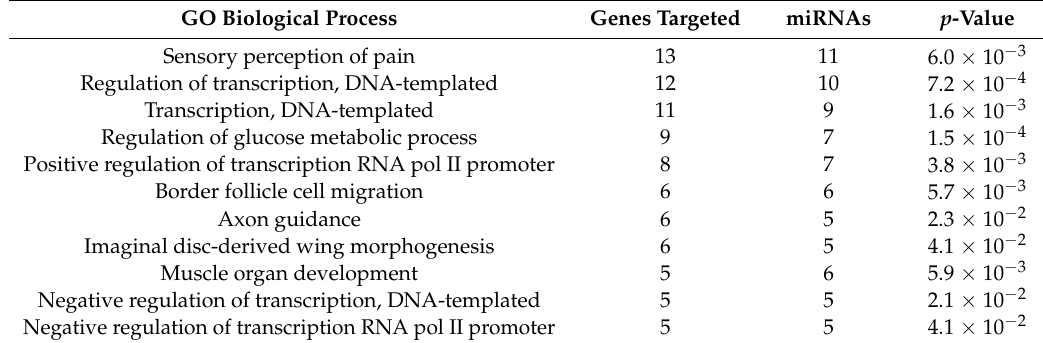
Table 5. Biological processes predicted to be modulated by select miRNAs with varying expression levels in imidacloprid-treated L. decemlineata